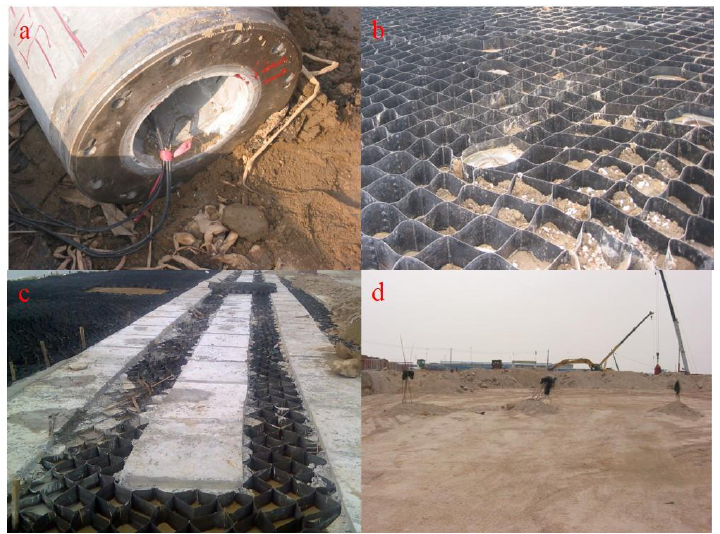
Figure 5. The steps used to install monitoring sensors in the riverbank slope: ( a ) sensor calibration; ( b ) geocell and anti-slide pile layout; ( c ) grouting and sealing; ( d ) filling. Based on the monitoring purpose and the working mechanism of the anti-slide piles and geocells, the following monitoring contents were formulated. Monitor the vertical and lateral displacements of the riverbank slope For the vertical displacement of the riverbank slope, 15 displacement meters were